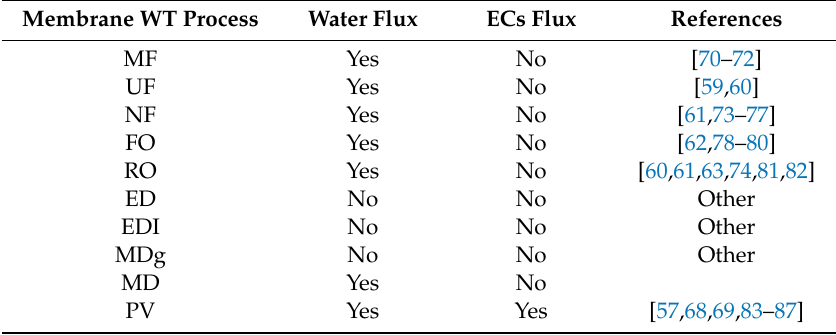
Table 3. Water and ECs flux through membrane in WT processes from Table 2. Neither of the two options involves the flux of any particles other than water or